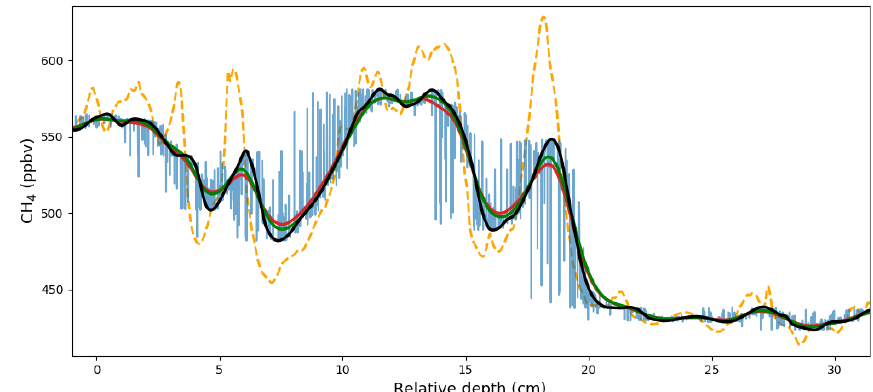
Figure 10. Impacts of layered trapping and smoothing on a hypothetical 1.5-million-year-old methane record. The signal without smoothing or artifacts is displayed in dashed orange. The recorded signal with layering is shown in light blue, and the recorded signal with smoothing only is shown in black. The synthetic CFA measurements taking into account the artifacts are displayed in red, while the synthetic measure- ments without artifacts are displayed in green. The synthetic depth scale is expressed relative to an arbitrary point of the record. For clarity the depth scale is expressed in centimeters.